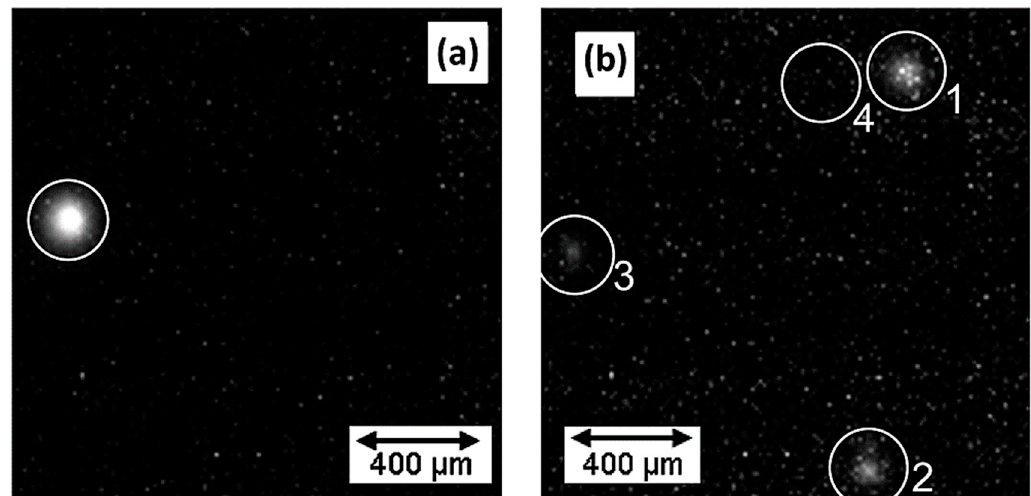
Figure 16. Discharge image captured by the high-speed camera when applied on ( a ) thick coating and ( b ) thin coating. Reproduced with permission from [144]. Copyright Elsevier, 2015.